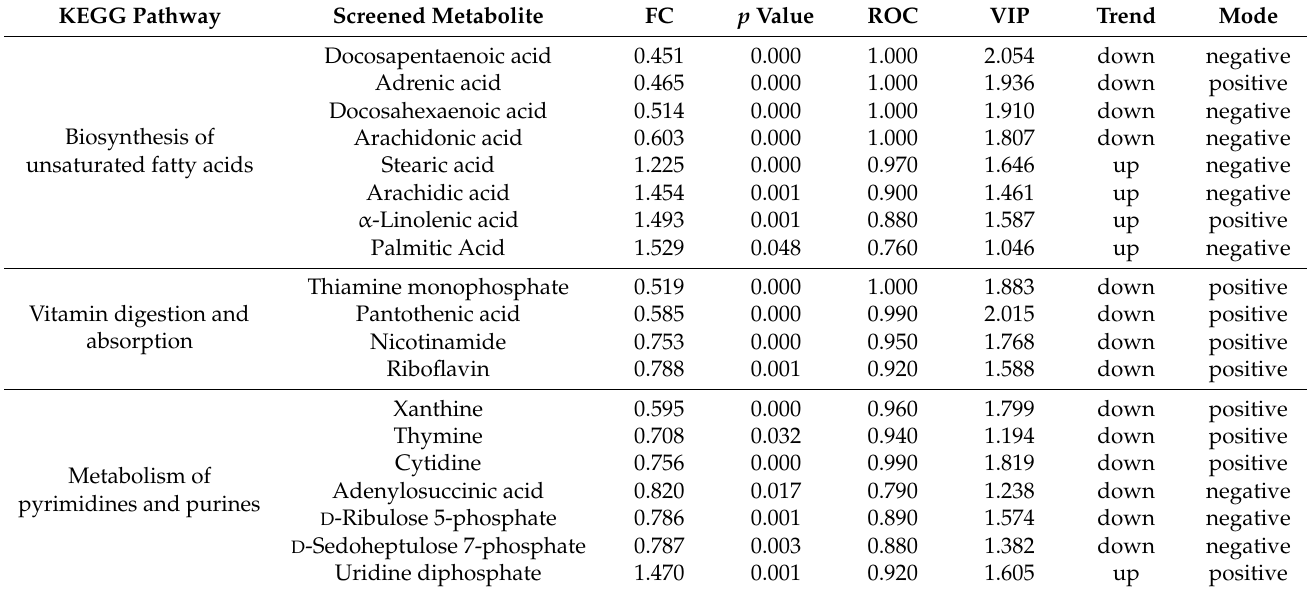
Table 2. The main KEGG pathways based on the differentially expressed